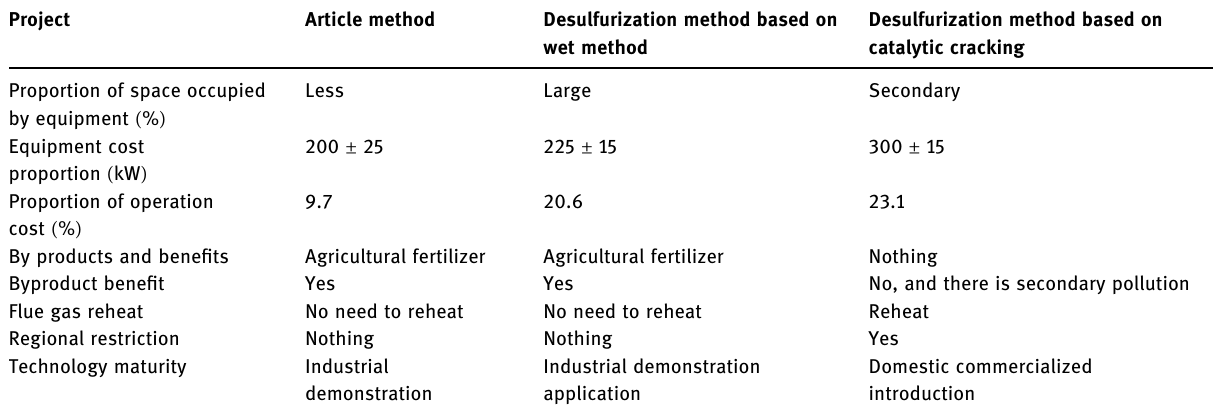
Table 3: Economic index analysis of deep desulfurization method of sintering fl ue gas